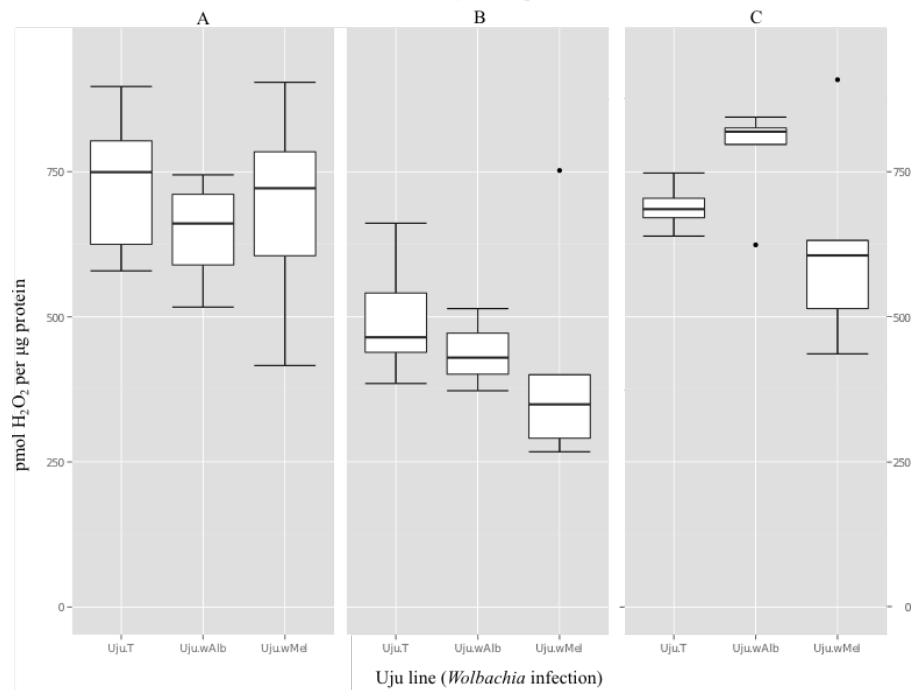
Figure 4. H 2 O 2 detected in adult homogenates of Ae. albopictus lines Uju.T, Uju. w Alb and Uju. w Mel, normalised to sample protein content. Data was obtained from six pools of three adult females per line in each of three independent experiments.